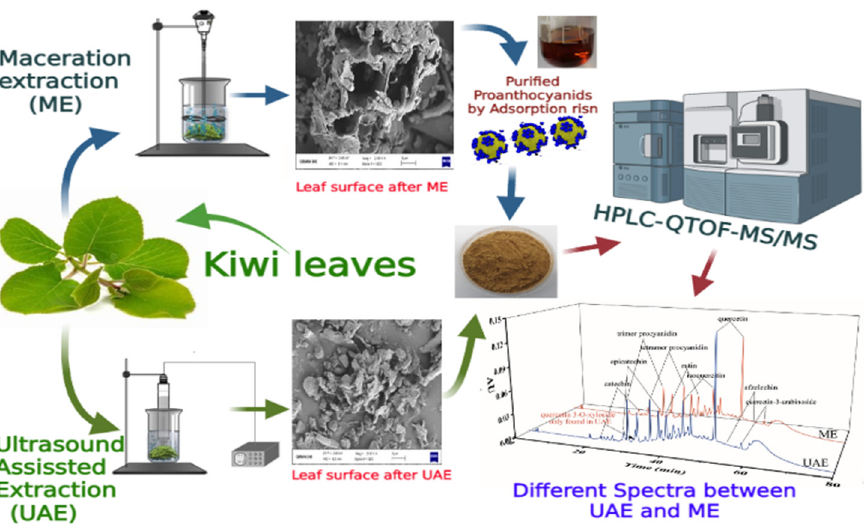
Figure 1. Flowchart of proanthocyanidins (PAs) extraction by ultrasound-assisted extraction (UAE) and Maceration extractrion (ME) methods.